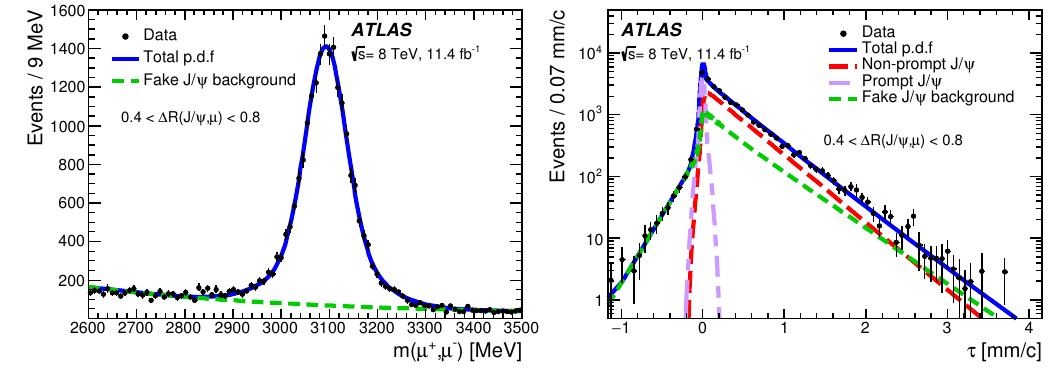
Figure 1 . The two-dimensional dilepton mass-pseudo-proper decay time (cid:12)t for a single di(cid:11)erential observable bin: 0 : 4 < (cid:1) R ( J= ; (cid:22) ) < 0 : 8. The points with error bars are data, plotted at bin centres. The solid line is the projection of the unbinned maximum-likelihood (cid:12)t to the data. The dilepton invariant mass projection (left) shows the total fake J= background component (dashed) in addition to the total p.d.f. The pseudo-proper decay time projection (right) also shows the prompt and non-prompt signal J= as dashed